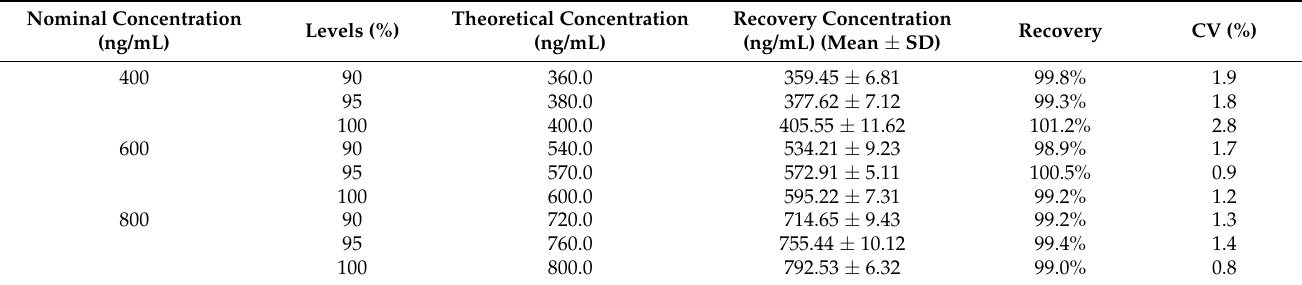
Table 6. % Recovery data of optimized bioanalytical method of ACV.